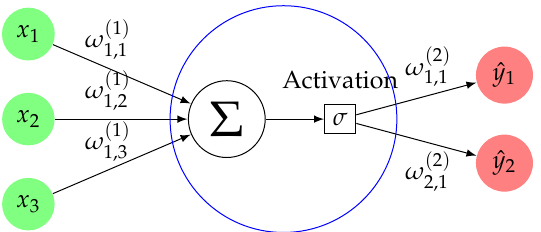
Figure 5. Process in each layer of the neural network. Step 1: linear combination. Step 2: application of the activation